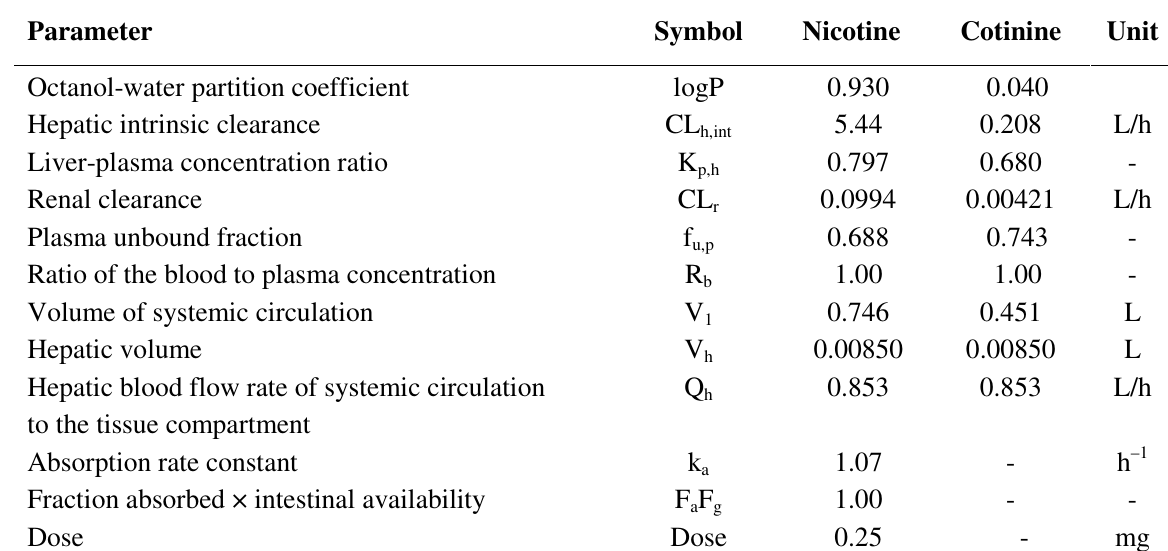
Table 1. Parameters used for the rat PBPK